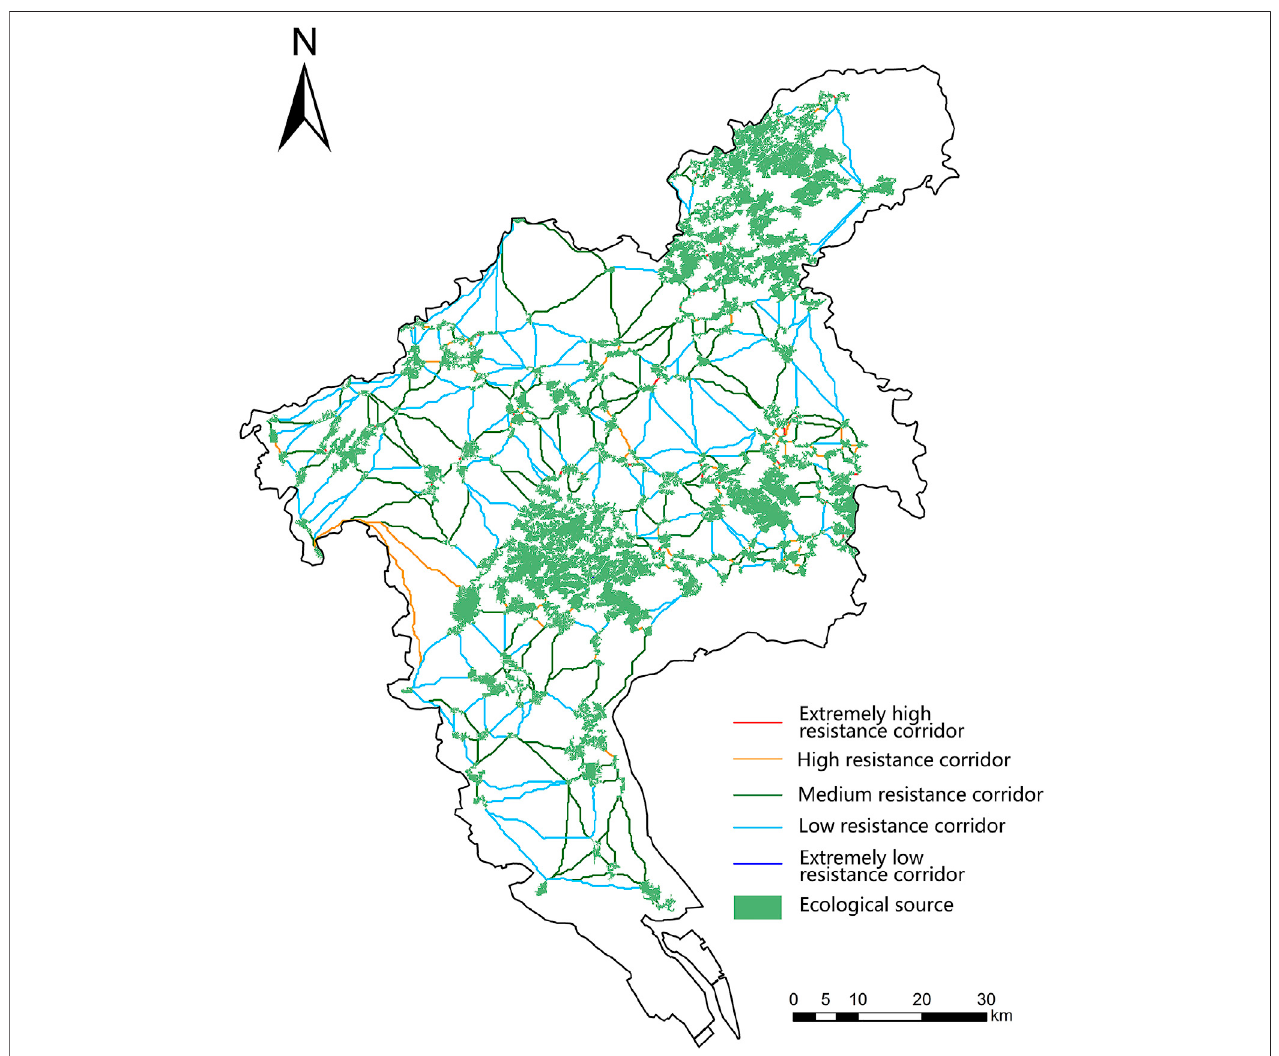
FIGURE 7 | Ecological source and